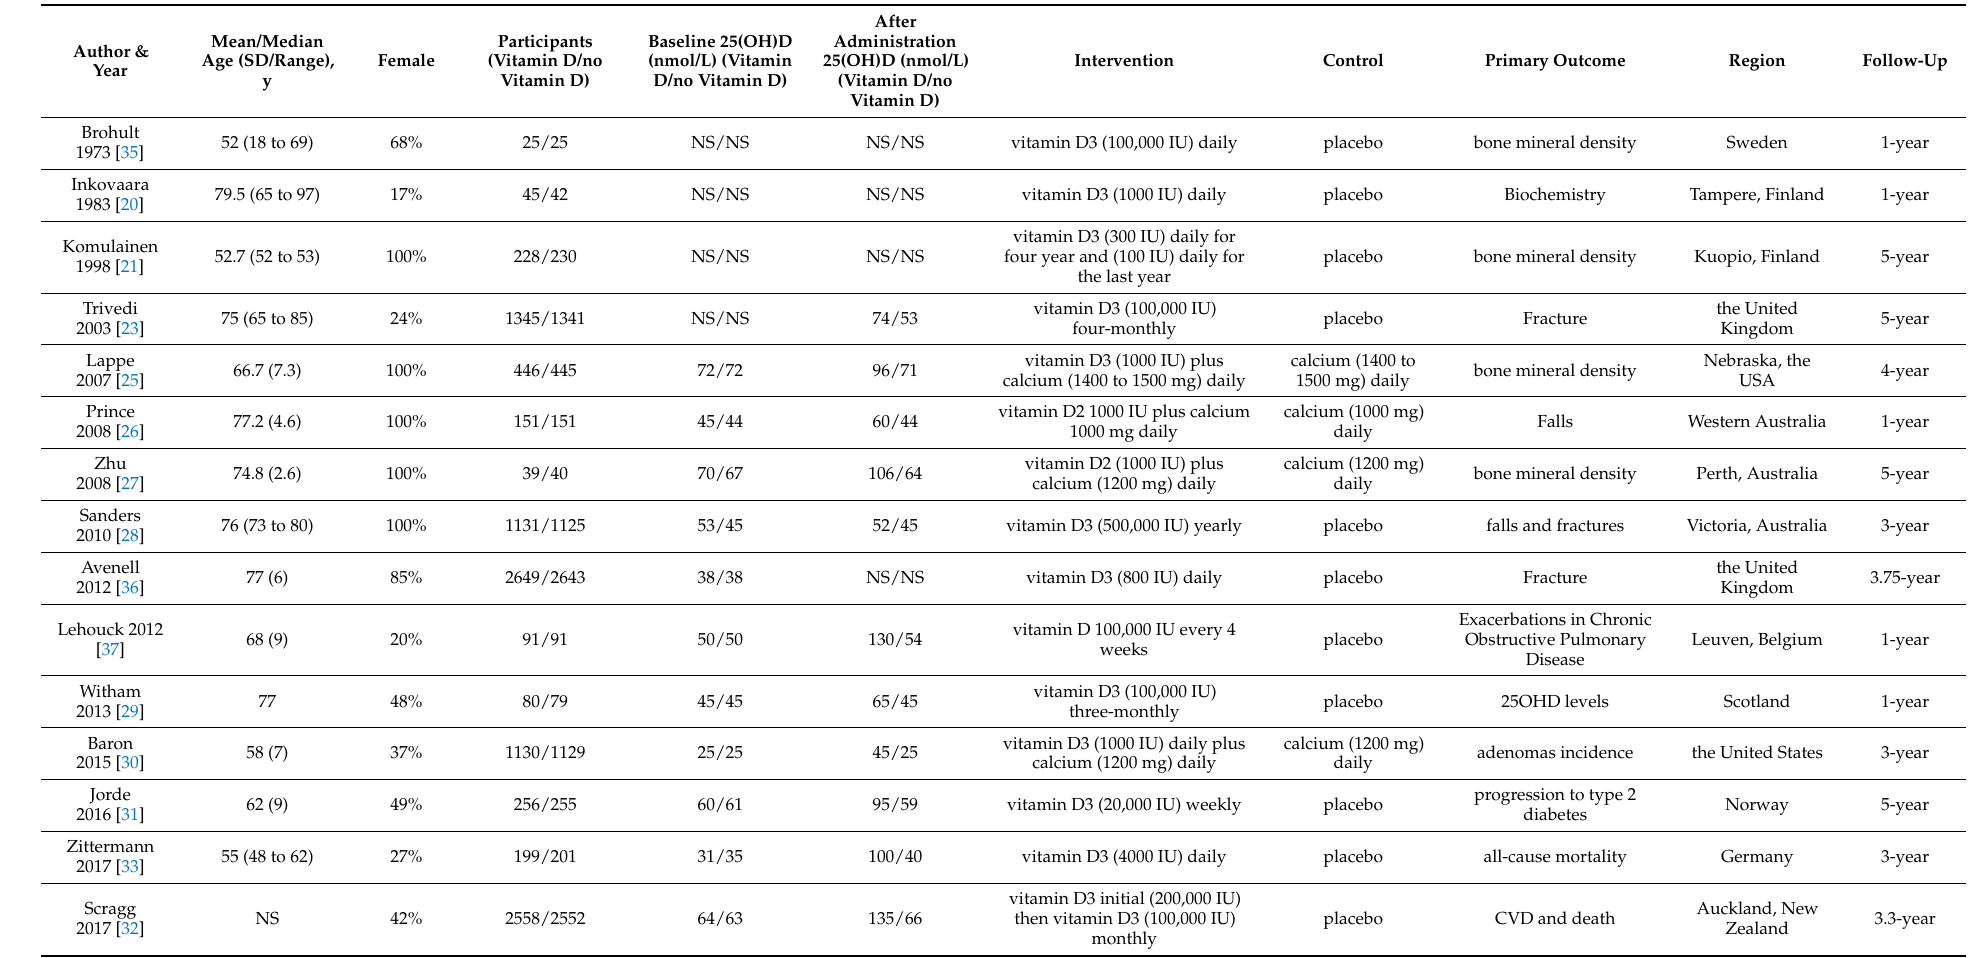
Table 1. Characteristics of the 18 Randomized Clinical